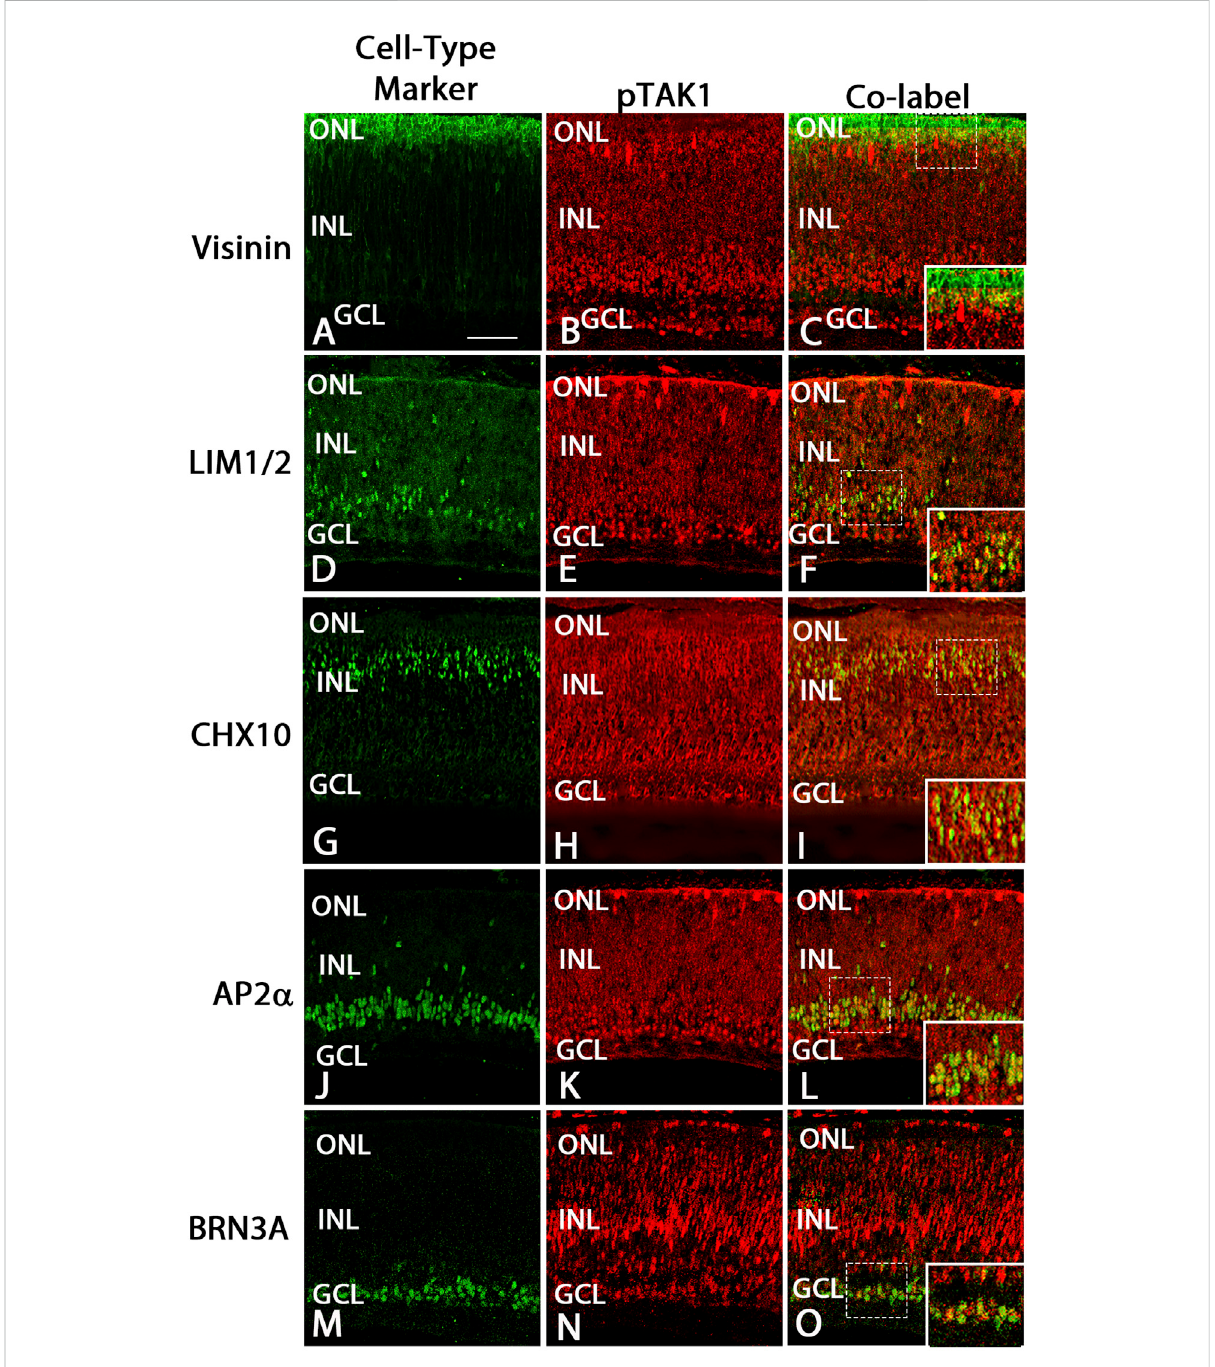
pTAK1 was localized to differentiating cells in E8 retina.Chick retinal sections from E8 embryos were double-labeled for pTAK1 and Visinin (cones; A – C ), LIM1/2 [horizontal cells; (D – F) ], CHX10 [bipolar cells; (G – I) ], AP2 α [amacrine cells; (J – L) ] or BRN3A [ganglion cells; (M – O) ].